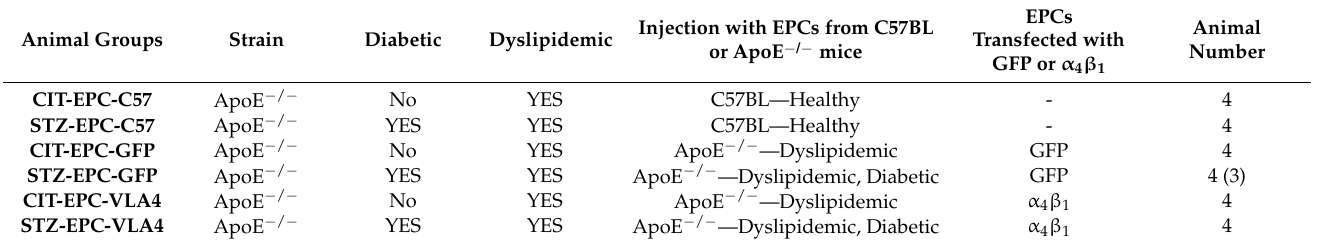
Table 1. Male mice were used for biochemistry, echocardiography and immunohistochemistry determi-